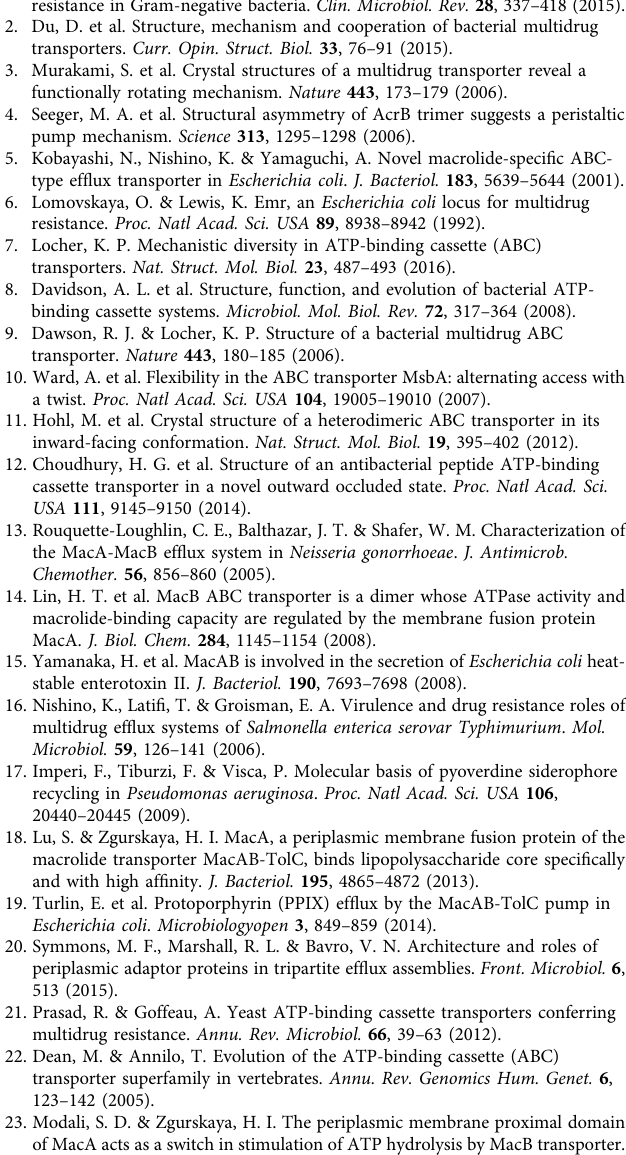
Measurement of cellular growth rates . Overnight cultures from glycerol-stocks of drug-hypersensitive E. coli Δ acrAB Δ macAB , harbouring pBAD plasmid encoding A. baumannii MacAB-TolC, MacA-TolC (inactive control) or none of these genes (inactive non-expressing control), were grown in Luria-Bertani broth containing